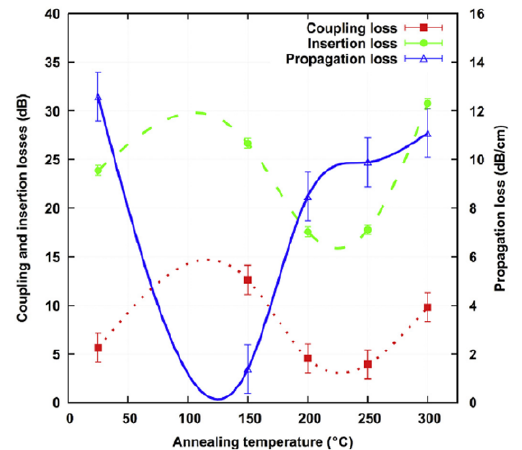
Figure 16. Losses vs. temperature of the 30-min annealing steps measured at 1400 nm. F = 4.6 · 10 14 ions/cm 2 [40].